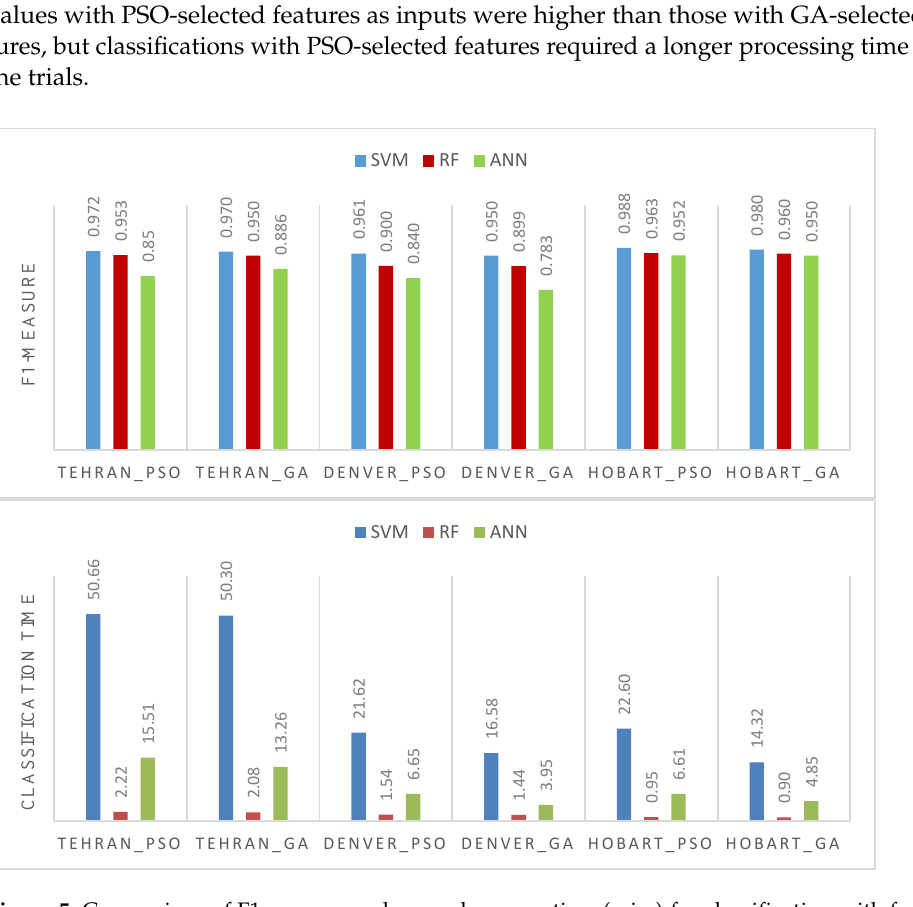
Figure 5. Comparison of F1-measure values and process time (min.) for classification with features selected by PSO and GA for Tehran, Denver, and